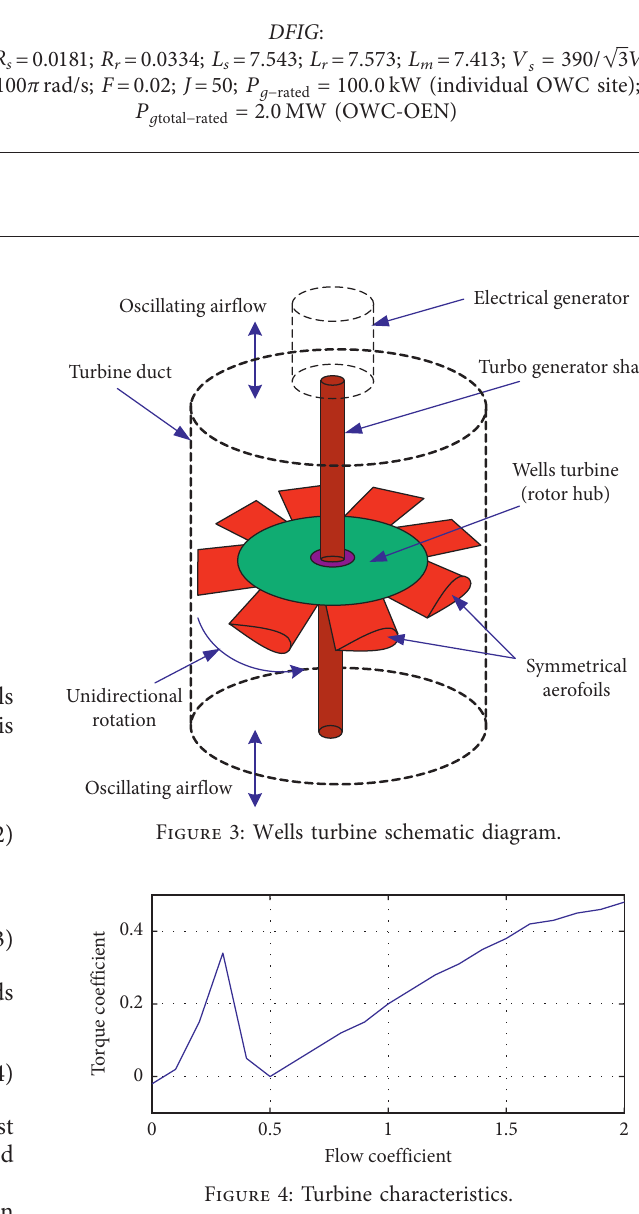
Figure 4: Turbine